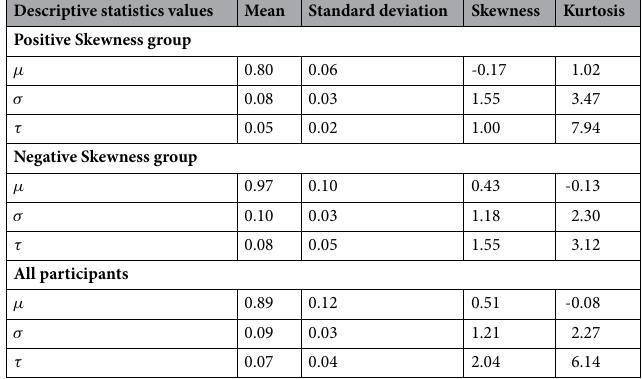
Table 1. Descriptive statistics values in exGaussian